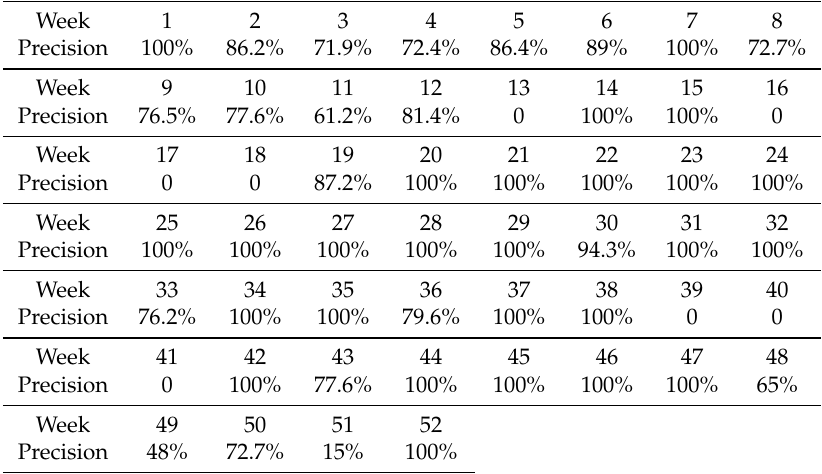
Table A2. The precision of anomaly detection results for the weekly data of School B.